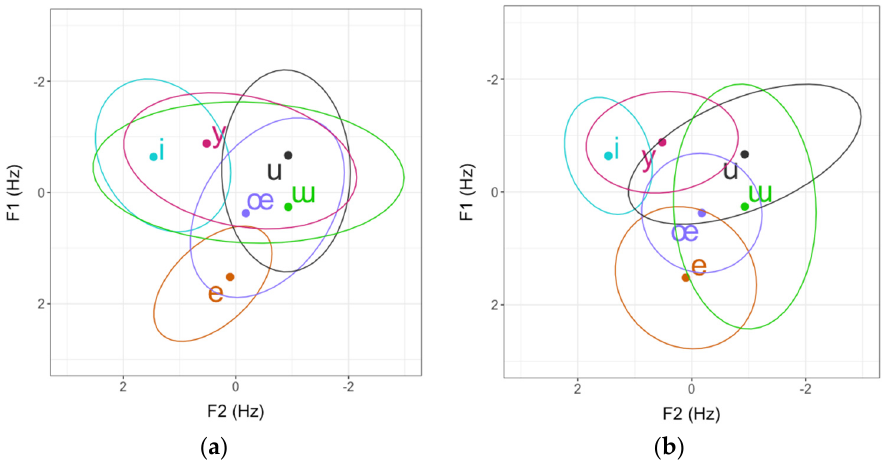
Figure 5. ( a ) Mean F1 and F2 values for L2 Turkish vowels produced by the speakers in the urban group. Each ellipse includes approximately 95% of the samples in each vowel category. ( b ) Mean F1 and F2 values for L2 Turkish vowels produced by the speakers in the regional group. Each ellipse includes approximately 95% of the samples in each vowel category.